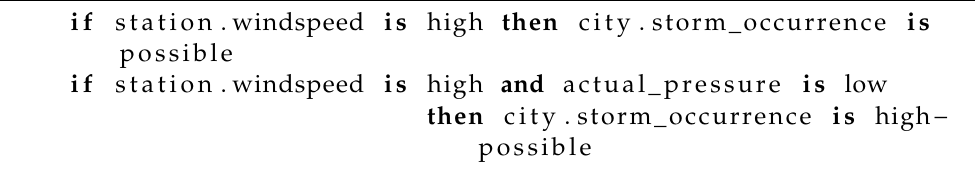
Figure 16. Fuzzy spatiotemporal predictive query flow. Query 4: Is there a possibility of a windstorm around Izmir during the last week of December? The FKB contains the following rules for meteorological events that occur depending on wind